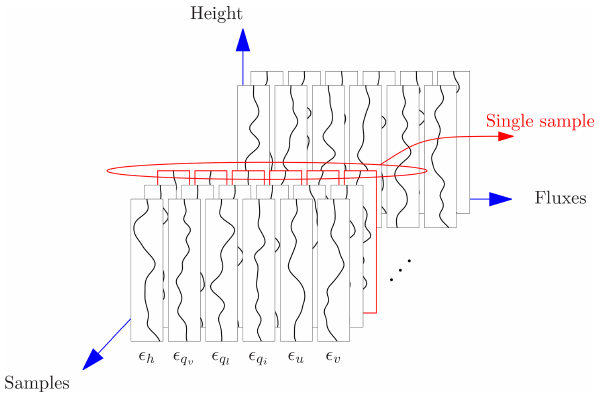
Figure 9. Schematic overview of the sampling of a grid column containing the different transport flux